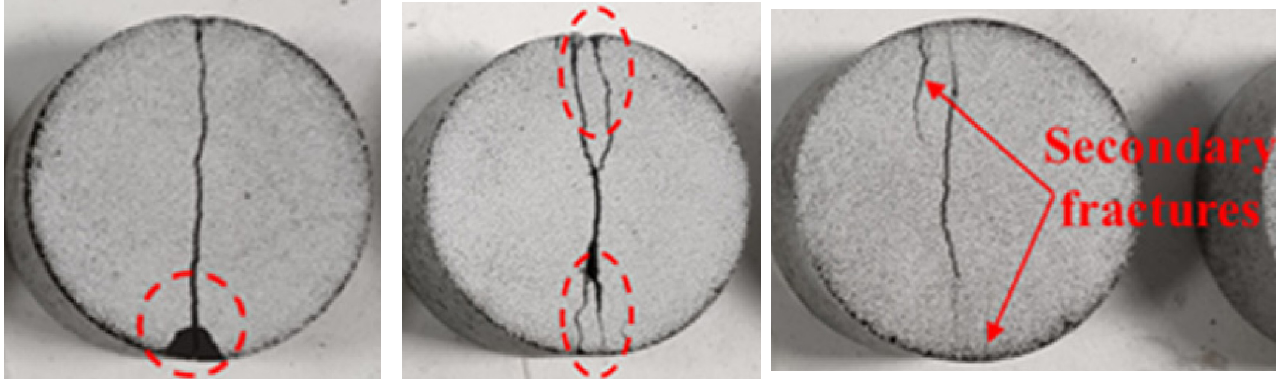
Figure 19. The failure mode of disc with different loading configurations in physical test [24].